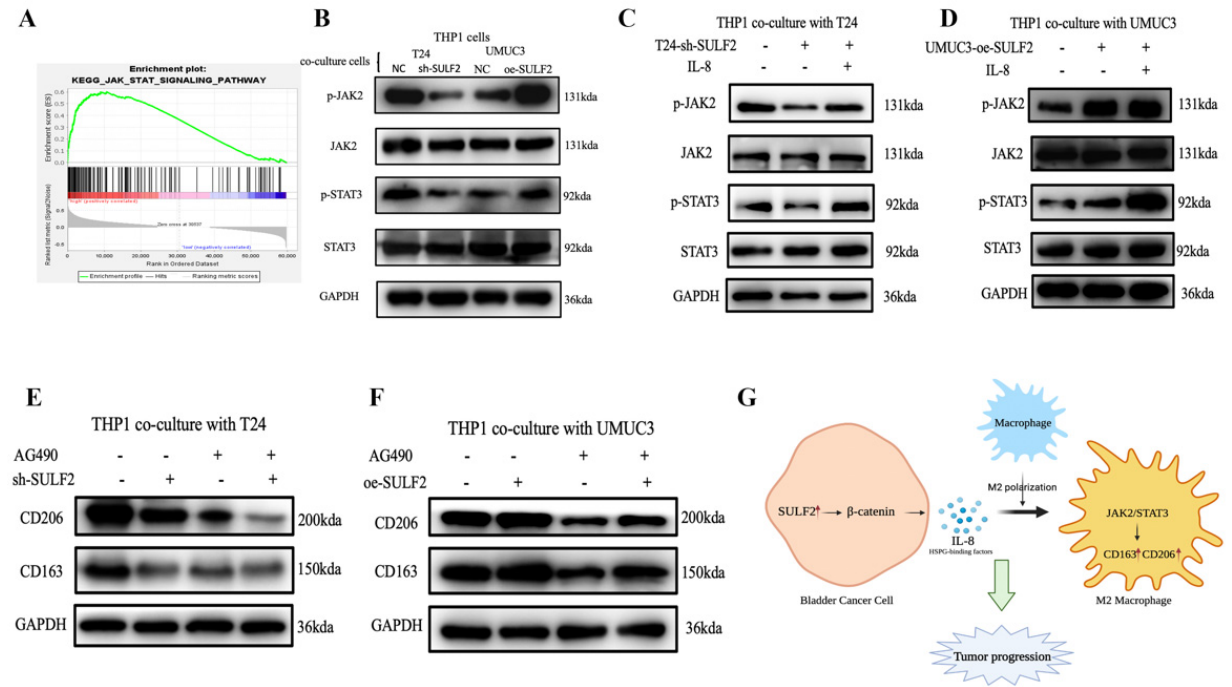
Figure 7. IL-8 promotes the polarization of macrophages through the JAK2/STAT3 pathway. ( A ) GSEA analysis showed that SULF2 was related to the STAT pathway in TCGA database. ( B ) The phosphorylation of JAK2 and STAT3 was detected by western blot after coculture of THP1 with BCa cells. ( C , D ) The phosphorylation of JAK2 and STAT3 was detected by western blot after exogenous addition of IL-8 to the coculture system. ( E , F ) The phosphorylation of JAK2 and STAT3 was detected by western blot after addition of the STAT3 inhibitor AG490 to the coculture system. ( G ) An illustration of the mechanism of SULF2 in the BCa microenvironment.